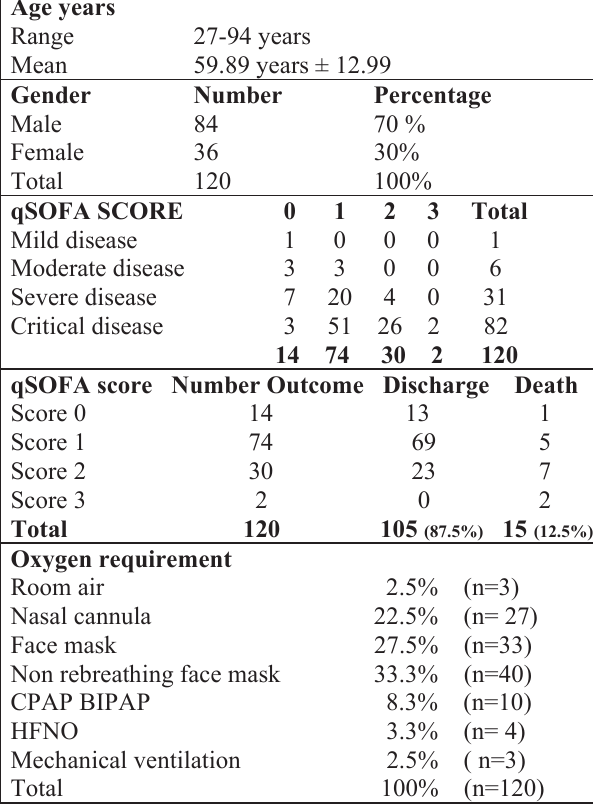
Table-1: Demographic details and Clinical Characteristics